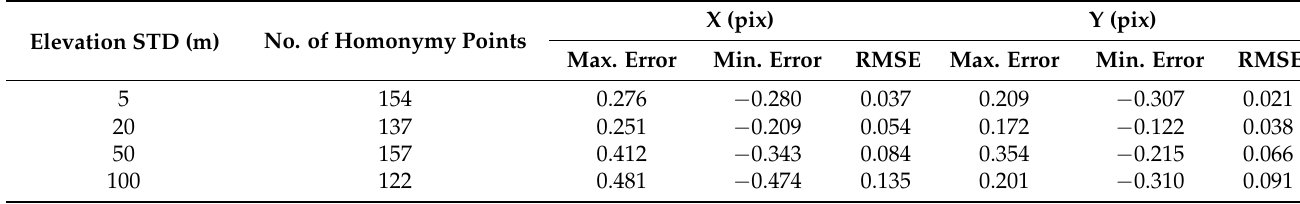
Table 6. Stitching error of EA-stable-2 (left-middle image).